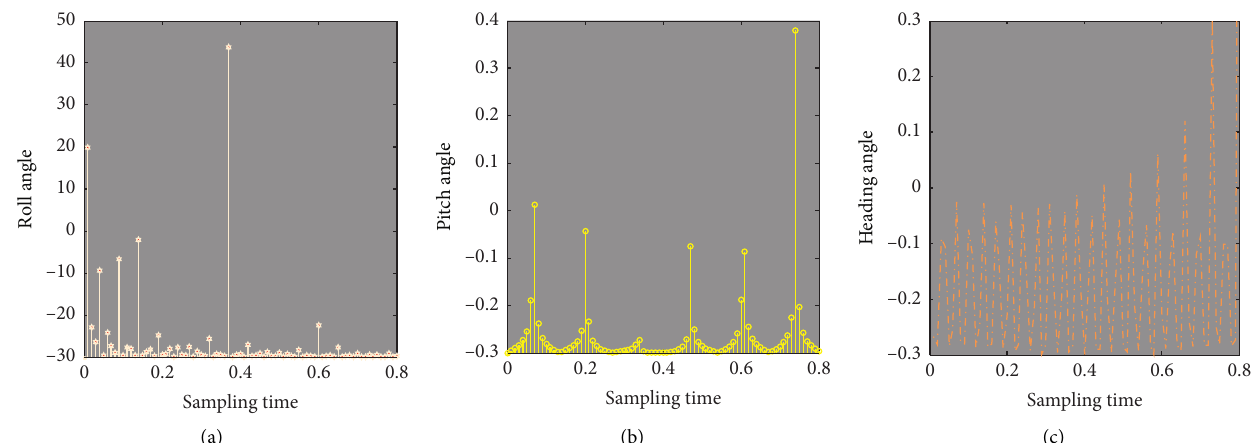
Figure 12: Action and attitude angle capture result: (a) action roll angle; (b) action pitch angle; (c) action heading